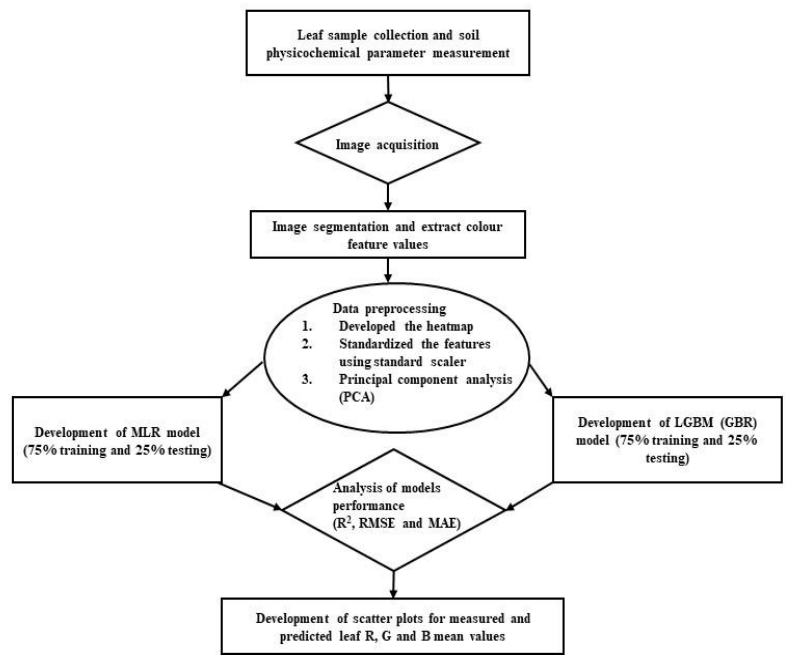
Figure 2. The flow chart of the procedure for the models’ development and analysis of performance using strawberry leaf R, G, and B mean values.